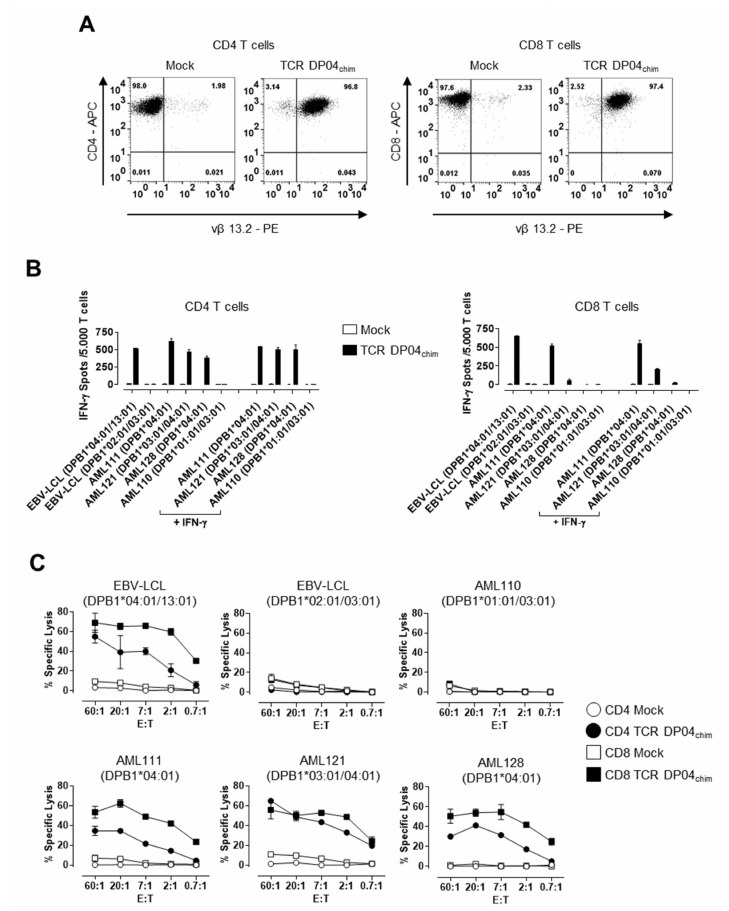
Figure 1. T cell receptor (TCR) expression and reactivity of TCR DP04 chim redirected T